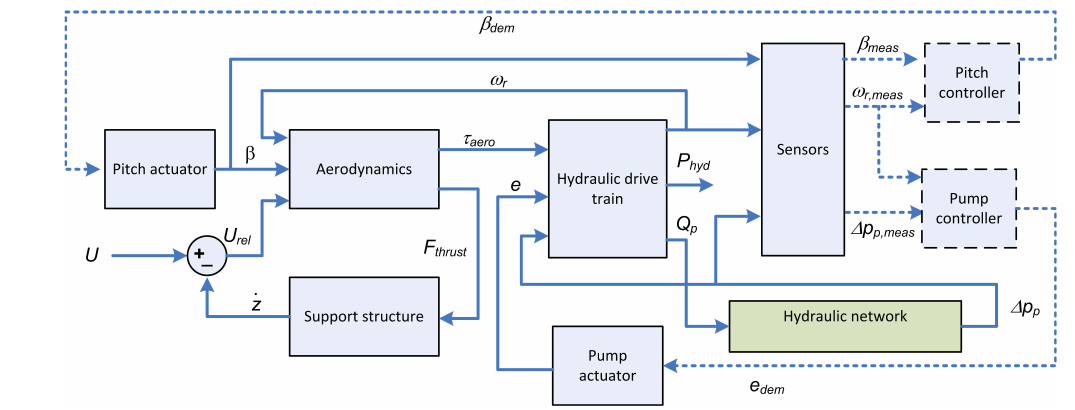
Figure 2. Subsystem block diagram of a single turbine connected to the hydraulic